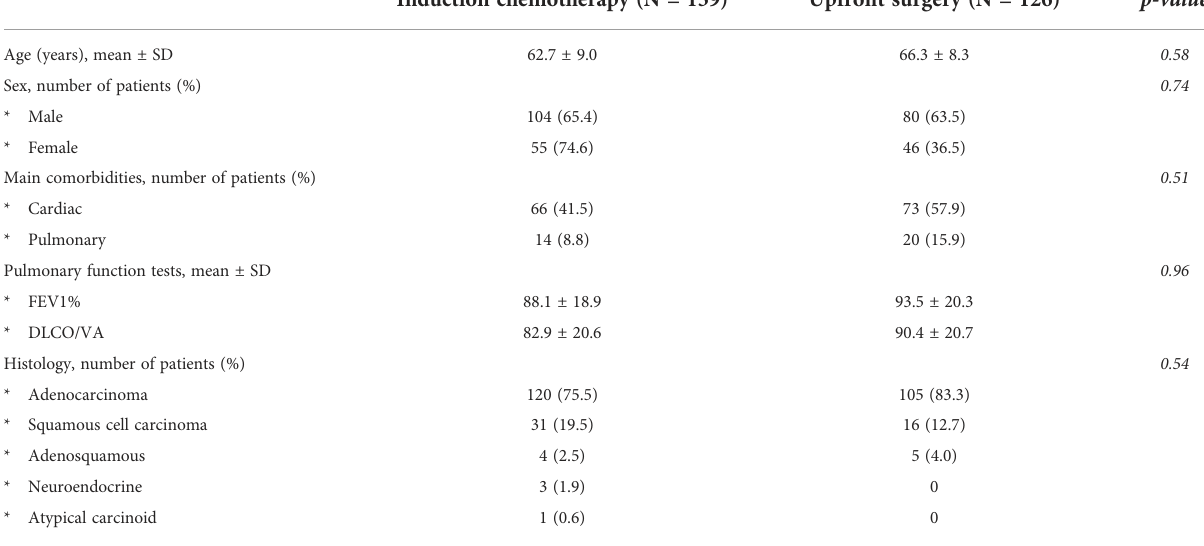
TABLE 1 Demographic characteristics of the study